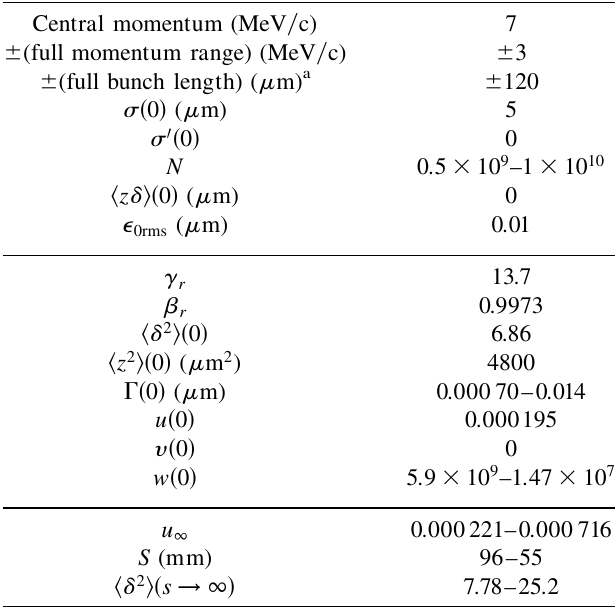
TABLE I. Example parameters in a plasma electron source, taken as typical from recent experiments